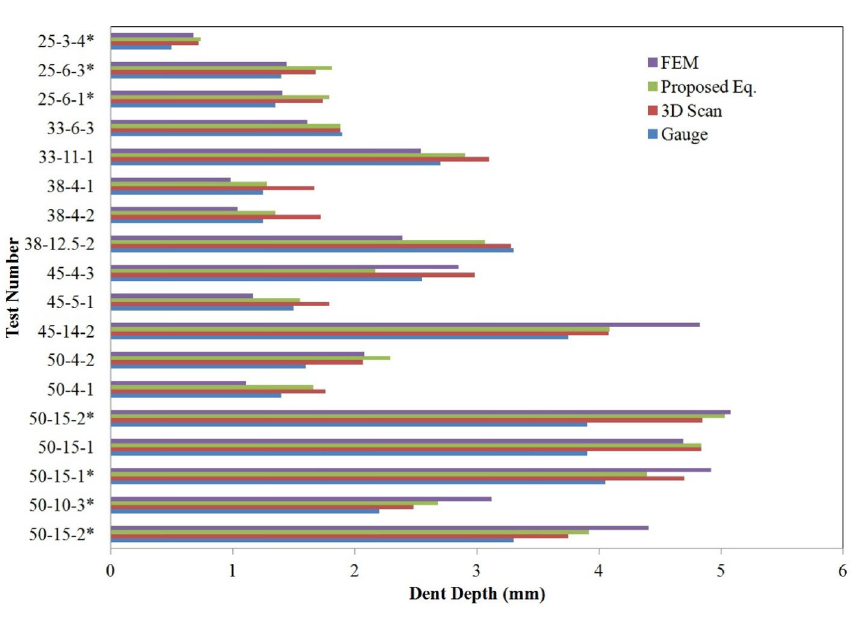
Figure 7. Comparison between the FE model and Wu’s 8